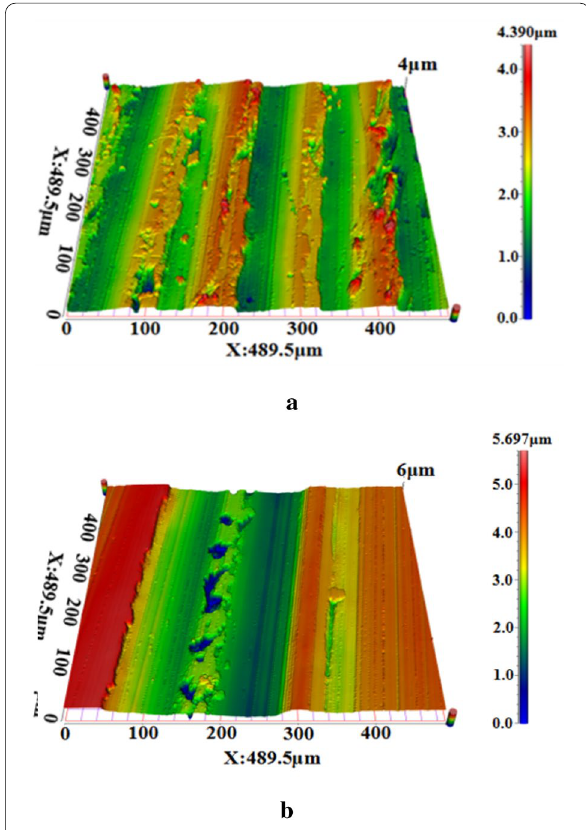
Figure 9 3D surface topography before and after optimization (90 r/ min): a before optimization, b after